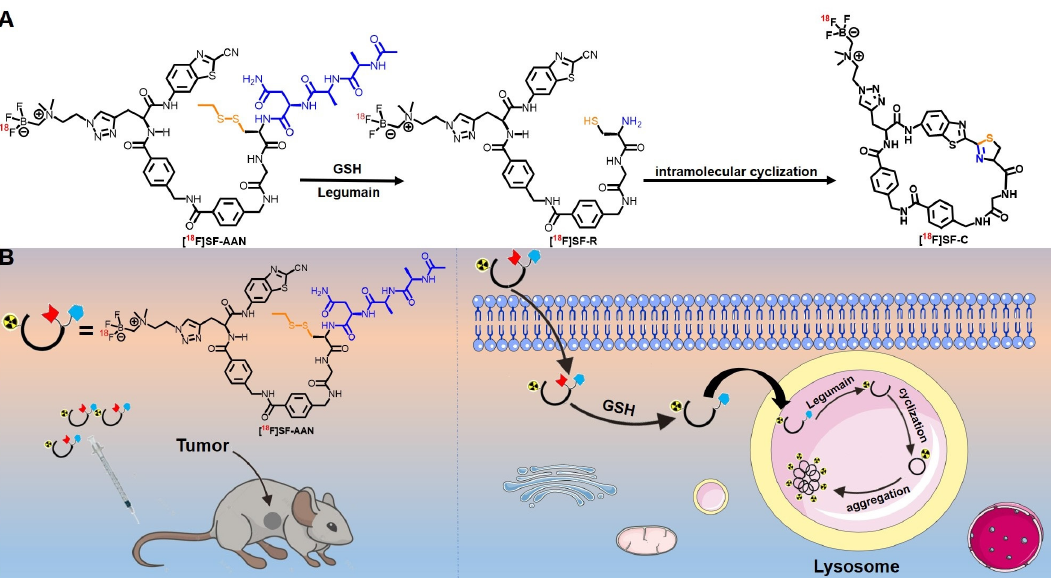
Scheme 1. Proposed mechanism of tracer [ 18 F] SF-AAN for PET imaging of legumain in vivo. ( A ) Un-